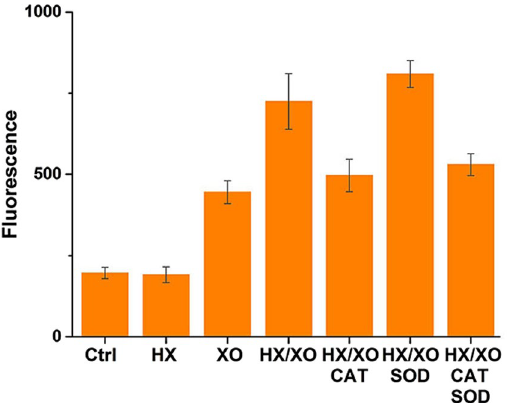
Figure 6. Effects of HX/XO on PLDz catalysis. Reaction condition: 50 nM PL B , 50 nM S BC , 10 μ M HX, 1 mU/ μ l XO (50 mU/ μ l CAT, 5 mU/ μ l SOD), 300 mM NaCl and 50 mM MES (pH 6.0) at 37 °C for 1